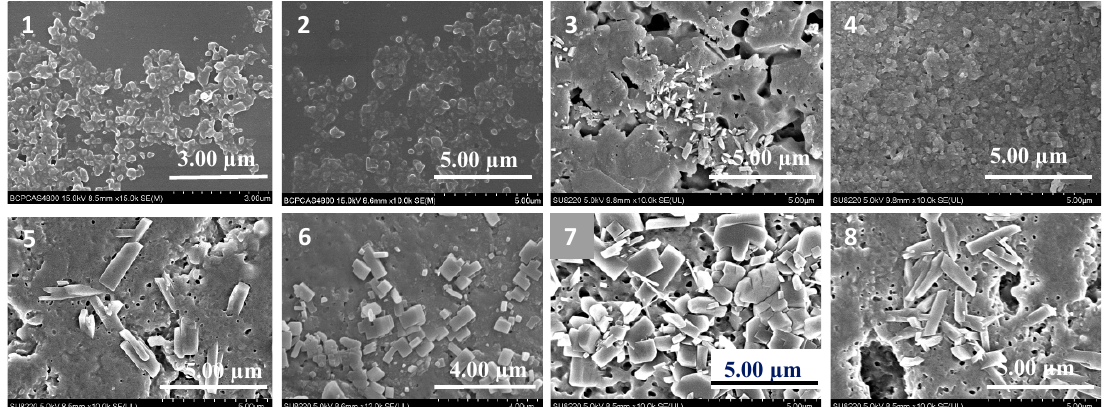
Figure 1. SEM images of the different formulations of MDZ/NCs. ( 1 ) HPMC/DOSS; ( 2 ) HPMC/SDS; ( 3 ) HPMC/PVP K30; ( 4 ) HPMC/CMC-Na; ( 5 ) HPMC/P407; ( 6 ) HPMC/P188; ( 7 ) HPMC/TW20; ( 8 ) HPMC/TW80.